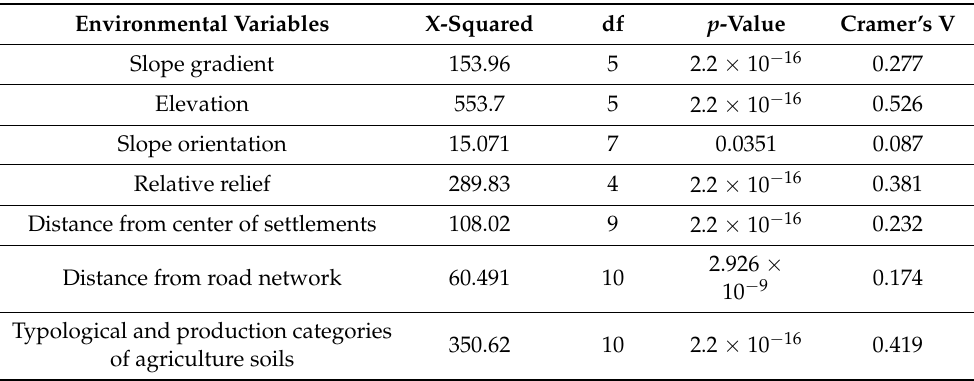
Table 2. Association between historical presence of wood pastures and evaluated environ- mental variables.